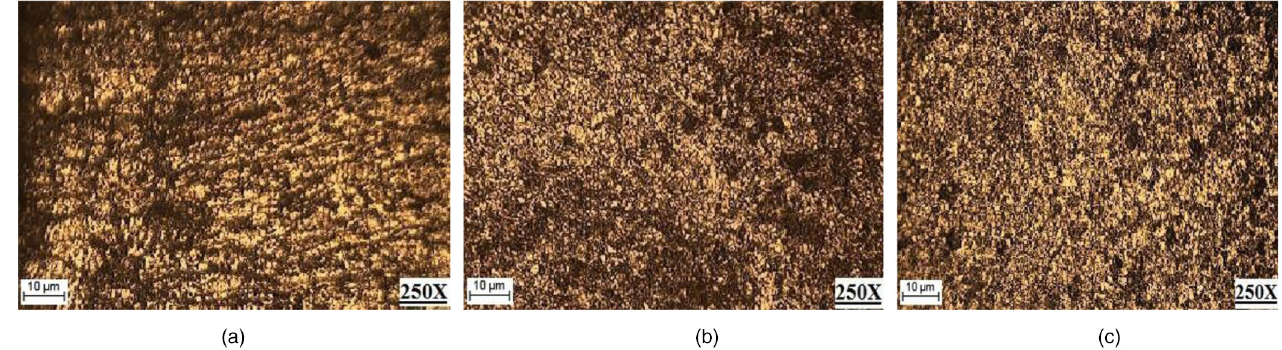
Fig. 4. Grain structure of 8 mm Tin castings for interior, middle as well as external surfaces for speeds of 850rpm. (a) 850 rpm interior surface. (b) 850rpm middle surface. (c) 850 rpm external surface.